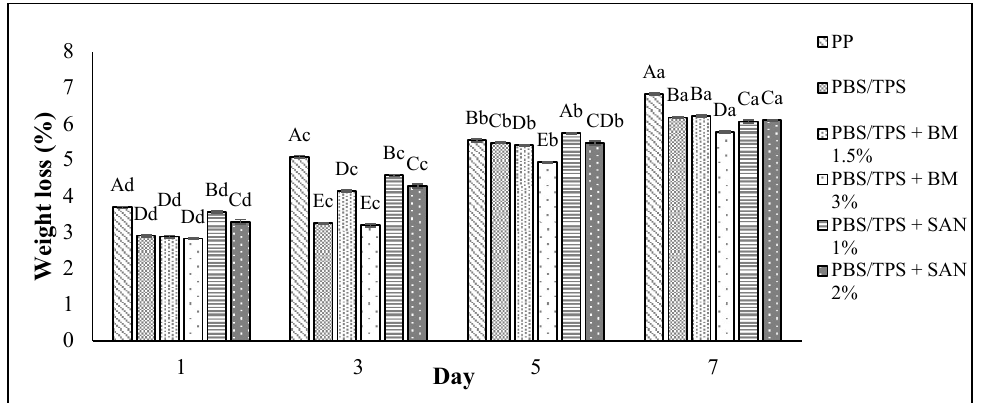
Figure 6. The weight loss values of chicken breast fillets stored in PP container and PBS/TPS film laminated tray during storage at 4 °C for seven days. Note: PP: polypropylene microwavable container (control); PBS/TPS: PBS/TPS film (untreated); PBS/TPS + BM 1.5%: PBS/TPS film + 1.5% Biomaster silver; PBS/TPS + BM 3%: PBS/TPS film + 3% Biomaster silver; PBS/TPS + SAN 1%: PBS/TPS film + 1% SANAFOR; PBS/TPS + SAN 2%: PBS/TPS film + 2% SANAFOR. Error bars indicate standard deviation (n = 3). The different A–E capital letters are significantly different ( p < 0.05) among treatment for each day. The different a–d lowercase letters are significantly different ( p < 0.05) among storage day for each sample.